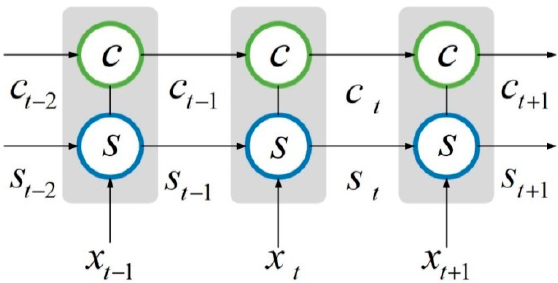
Figure 3. Schematic diagram of the hidden layer of the LSTM neural network.